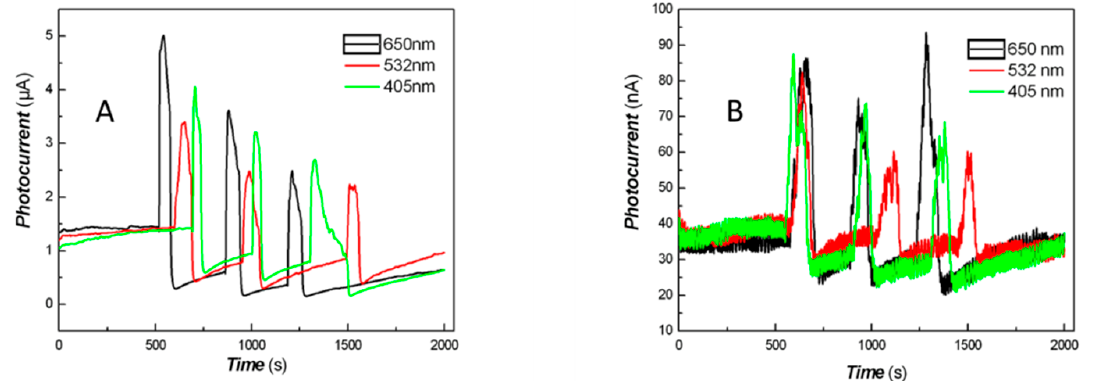
Figure 11. Photo-responses of Au/PANi nanocomposites functionalized with beta-cyclodextrin to 50 mW 405 nm, 532 nm, and 650 nm light ( A : Sample 2–chloroauric acid (50 mL); B : Sample 3–chloroauric acid (100 mL)).